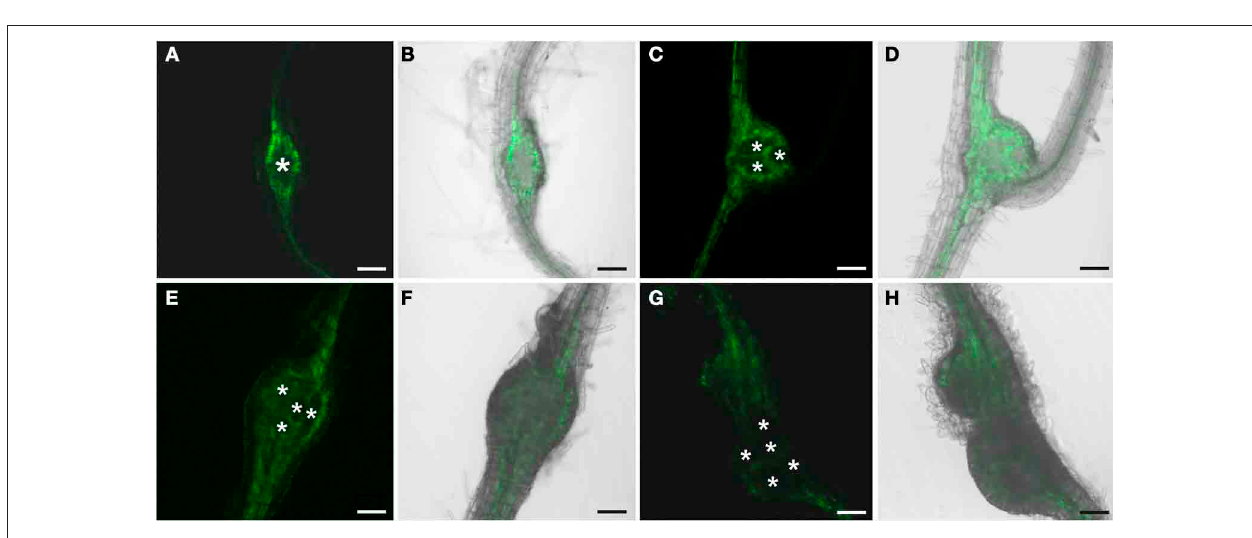
FIGURE 3 | GFP fluorescence in roots of P DR5 :ER - GFP Arabidopsis plants infected with M. incognita . Fluorescence is observed in auxin responsive tissues. Note the net-like structure of the tissue consisting of cells displaying